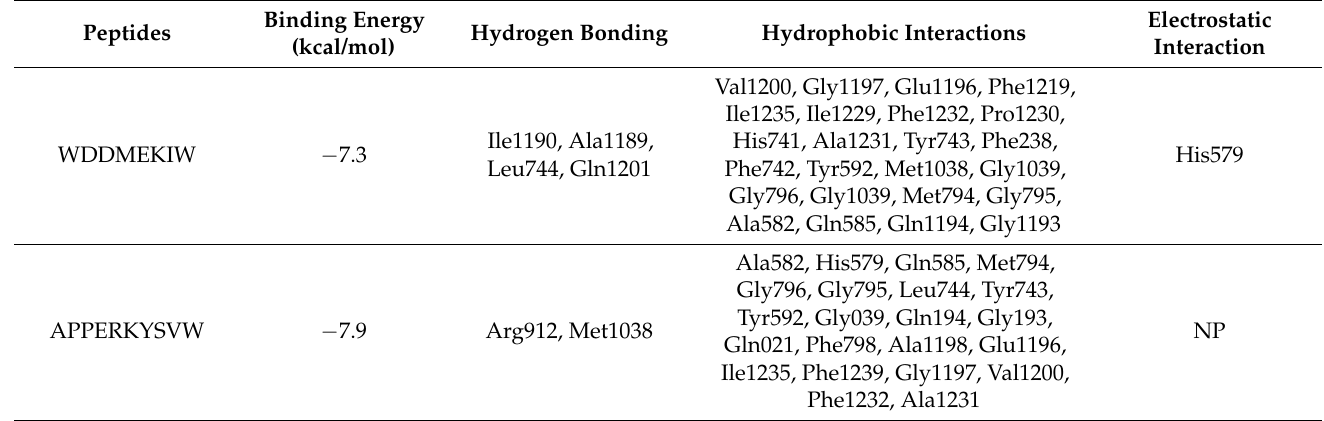
Table 4. The interaction types and amino acid residues of peptides with